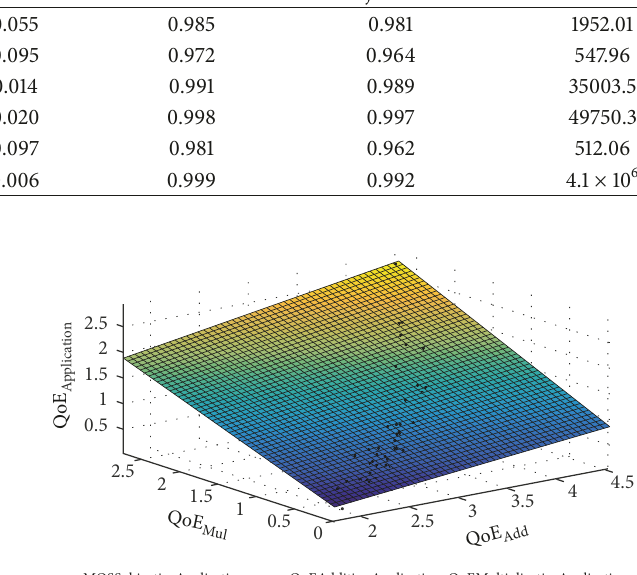
Figure 16: The application video